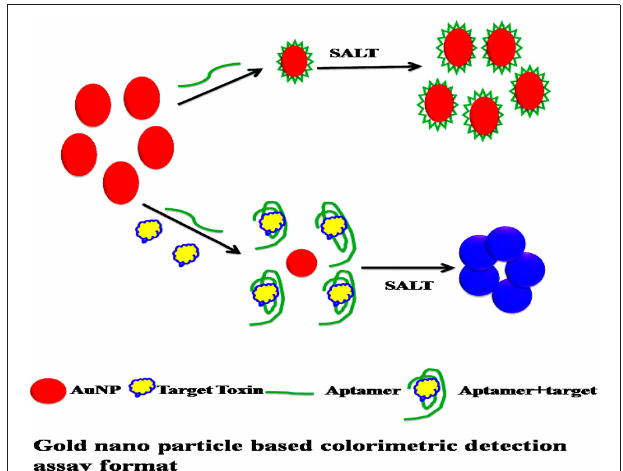
FIGURE 1 | Gold nano particle based colorimetric detection assay format.